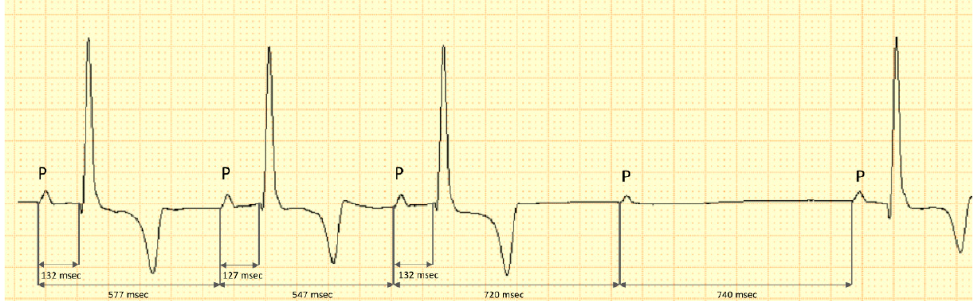
Figure 2. Capture of the electrocardiogram in lead II of a dog with severe azotemia. The fourth P-wave is blocked and no associated QRS complex is visible. There is no evidence of PR interval prolongation before the blocked P-wave, however, a P–P prolongation is present prior and after the occurrence of the bock. This may be indicative of the vagal activity on the sinus node, decreasing the atrial rate after inspiration phase; calibration 10 mm/mV, 50 mm/sec.